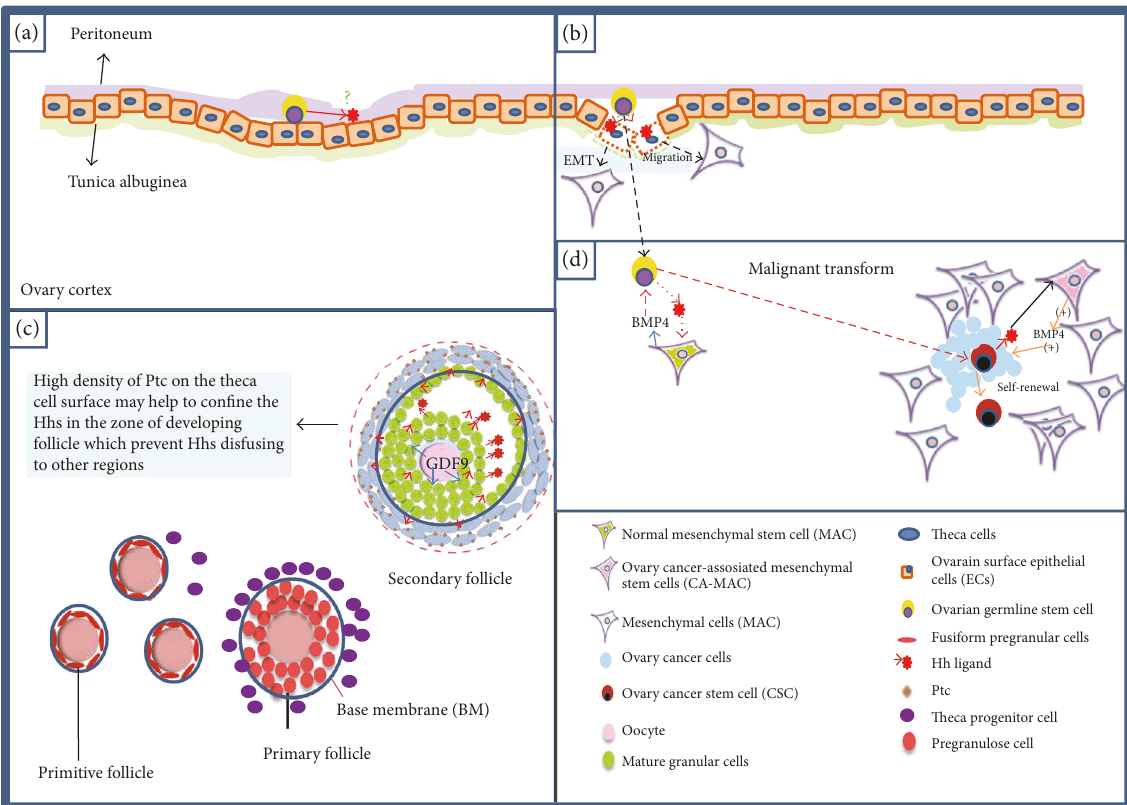
Figure 3: E ff ect of the Hh signaling pathway on the behavior of OGSCs in mammals. (a) It is not clear whether OGSCs in the ovarian surface epithelium (OSE) secrete Hh. (b) It is thought that the EMT could help OGSCs migrate to the ovary cortex from the OSE. (c) Ptc in TCs assists in preventing the Hh ligand from di ff using to other developing follicles and the interstitial stroma. (d) CSCs of ovarian cancer are likely to be the malignant transformation products of OGSCs. There is a BMP4-Hh feedback loop between CSCs and CA-MACs that promotes CSC proliferation and maintains the CSC number. It has not been determined whether there is a similar BMP4-Hh feedback loop between OGSCs and